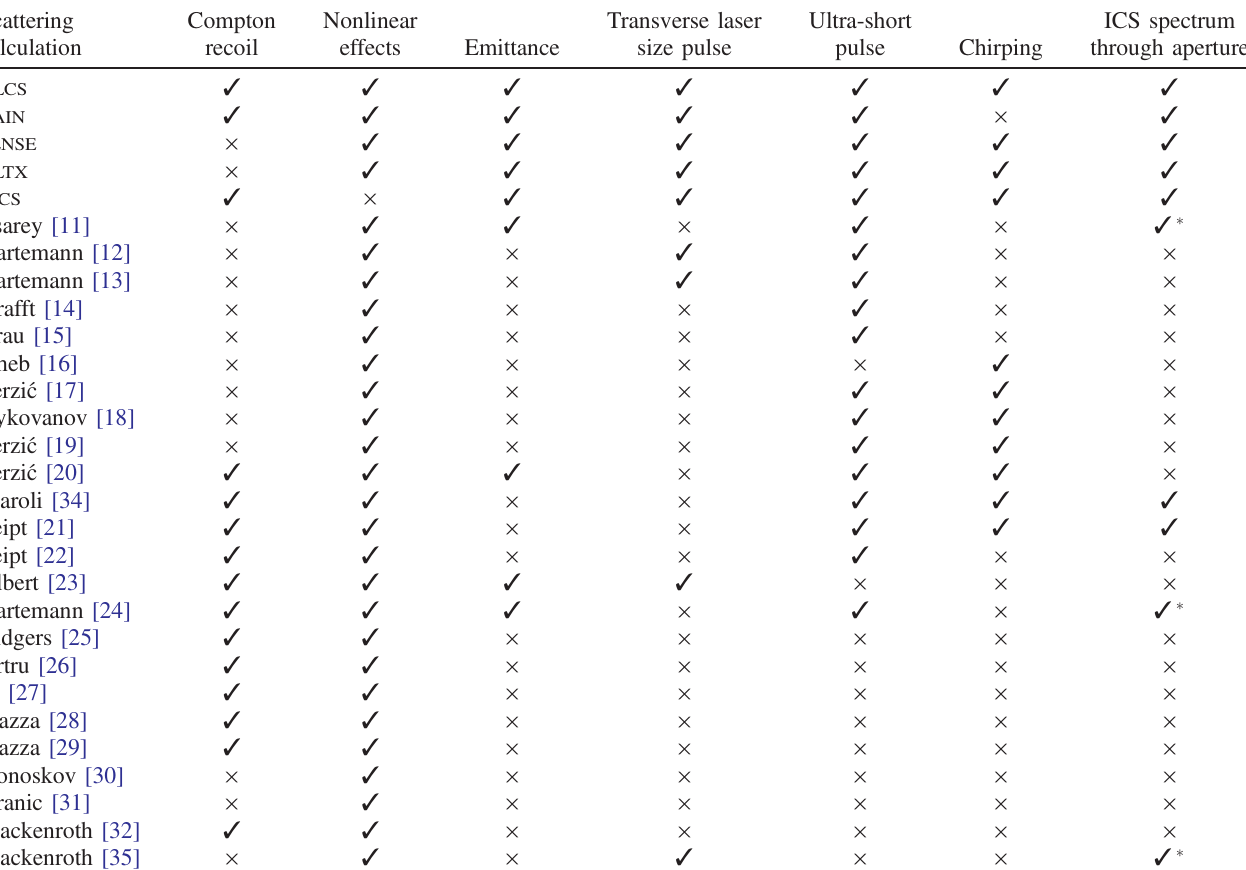
TABLE I. Comparison of the physics captured by prominent photon-electron scattering calculations. The symbol ✓ (cid:1) indicates that the calculation accounts for the angular distribution of the scattered photon energy without demonstrating the aperture effect on the spectral